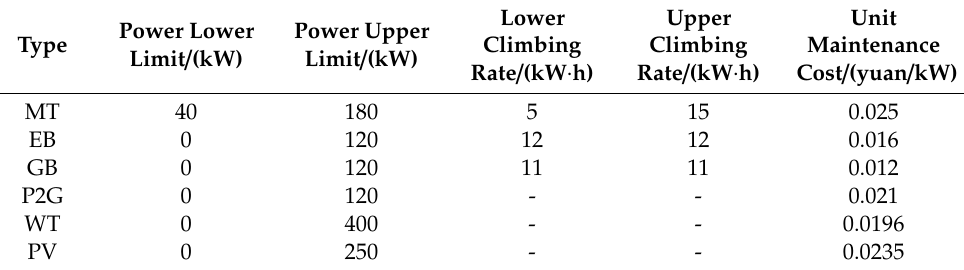
Table 1. The operating parameters of the equipment in the RIES.